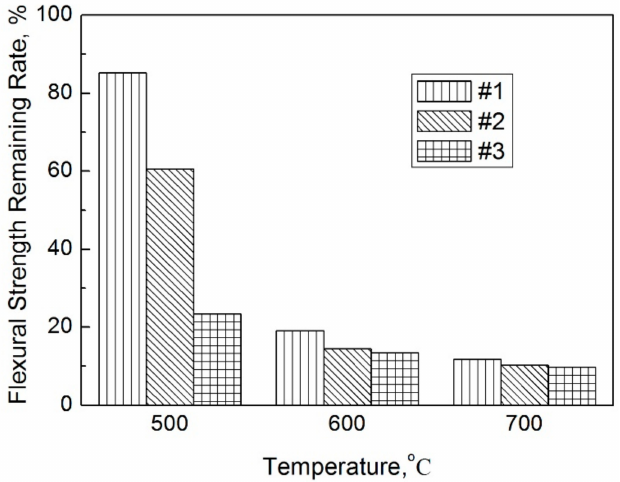
Figure 8. Flexural strength remaining rate of the Si 3 N 4 –MoSi 2 composites at various temperatures.